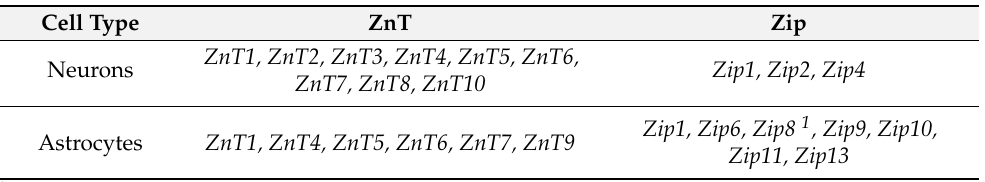
Table 1. List of zinc transporters that are expressed in a cell type-specific